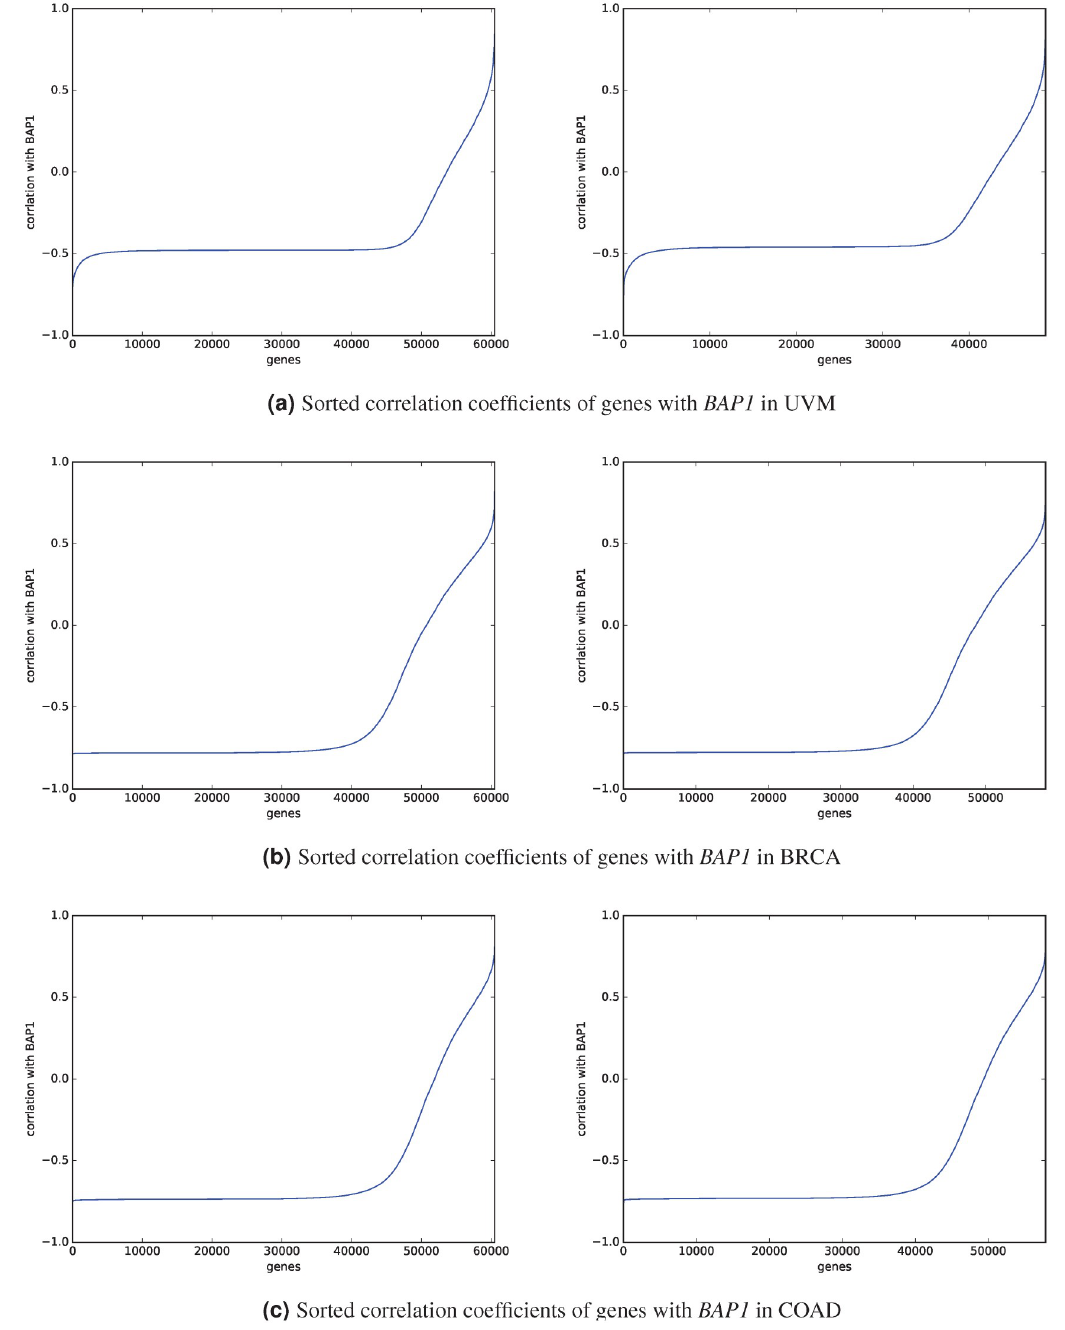
Fig 5. Sorted correlation coefficients of genes with BAP1 . The left sub-figure shows the sorted correlation of all genes with BAP1 in the dataset including genes with zero-values. The right sub-figure shows the results after using n-normalization (excluding genes with zero-values in the entire dataset).